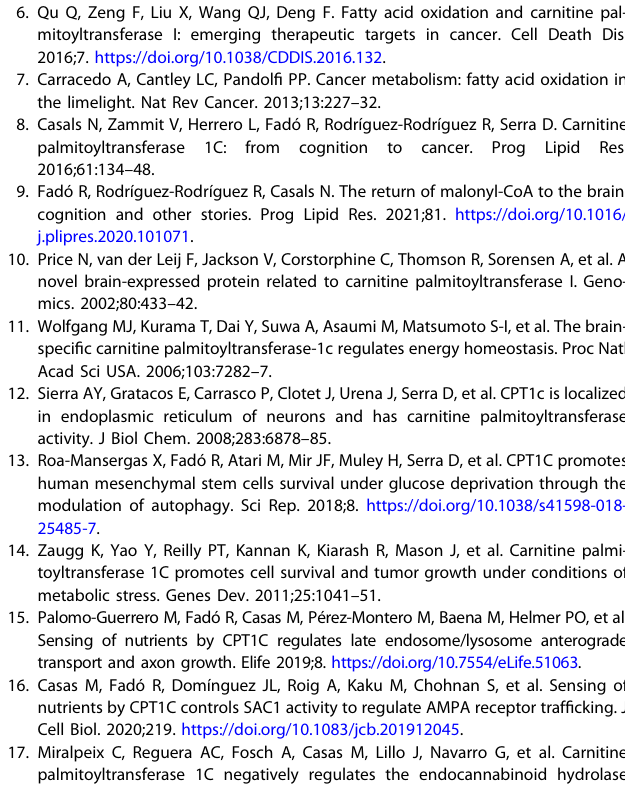
Fig. 5 CPT1C regulates the function of key proteins involved in cancer growth and metastasis. CPT1C has inef fi cient catalytic activity but is able to interact with and regulate the function of other proteins. At the membrane contact sites between the ER and the trans-Golgi network (TGN), CPT1C downregulates the activity of the phosphatase SAC1, favoring the increased PI4P levels necessary for the secretory pathway, and consequently, for remodeling of the extracellular matrix, angiogenesis, and cancer cell migration and invasion. Moreover, PI4P at TGN is necessary for ef fi cient transport of cholesterol and sphingolipids to the plasma membrane, and so can contribute to those processes. At the ER-late endosome (LE) contacts, CPT1C enhances the function of protrudin, which is necessary for anterograde LE transport and for protrusion growth, and therefore, for tumor invasion and metastasis. CPT1C also interacts with the hydrolase ABHD6 and downregulates its activity. This downregulation of ABHD6 increases levels of the endocannabinoid 2-araquidonoylglicerol (2-AG), which, through the CB1 receptor, possibly regulates mitochondrial function. ABHD6 also controls levels of the bis(monoacylglycero)phosphate (BMP) lipid, which is enriched in the intraluminal vesicles of LE and is involved in lipid metabolism and transport. ABHD6 has been associated with tumor growth and metastasis. Finally, we postulate that CPT1C at mitochondria – ER contacts may interact with and regulate some unknown mitochondrial protein triggering changes in mitochondrial function, and additionally postulate that CPT1C locally sequesters malonyl-CoA, and consequently, increases CPT1A activity and FA